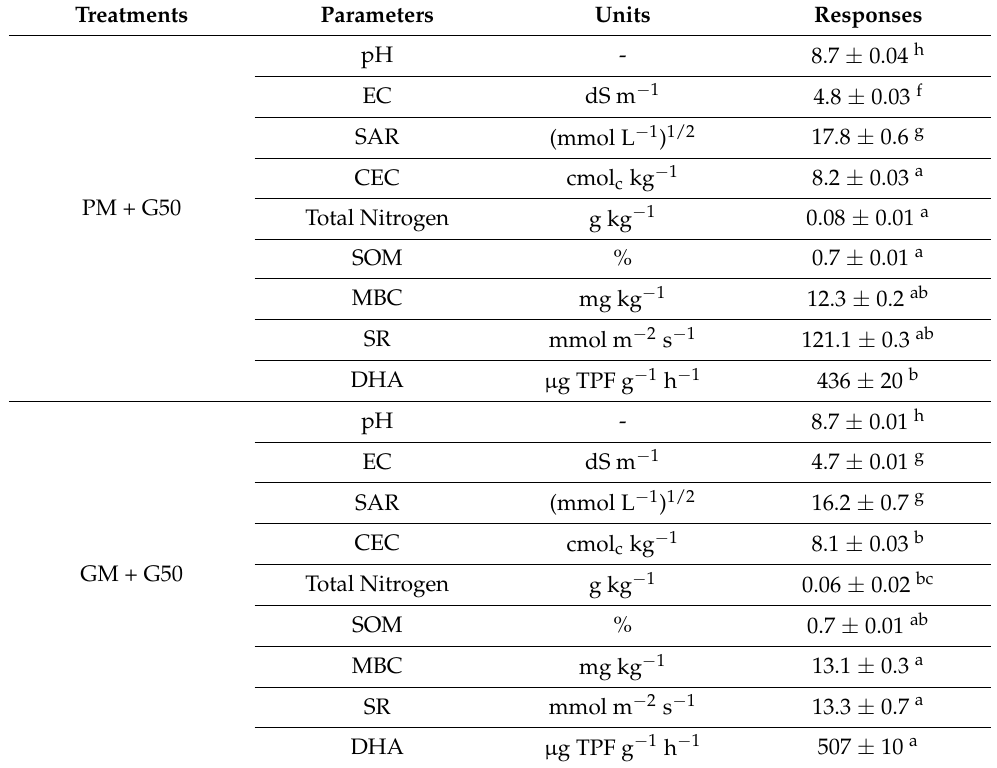
Table 2. Cont. Treatments Parameters